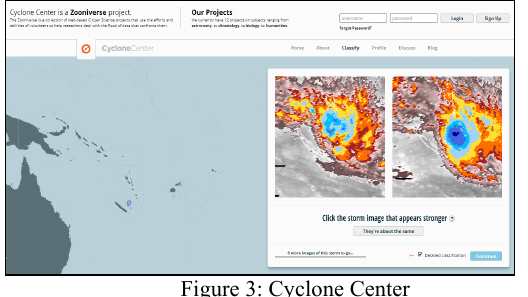
Figure 7: Project